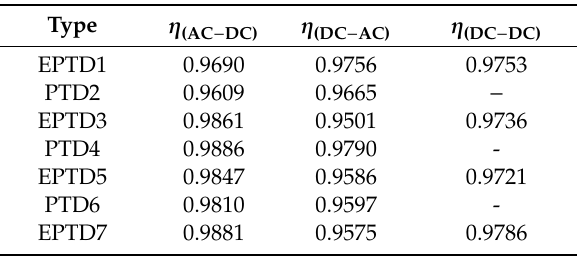
Figure 15. The diagram of the modified power supply system. Table 1. Converter efficiency.